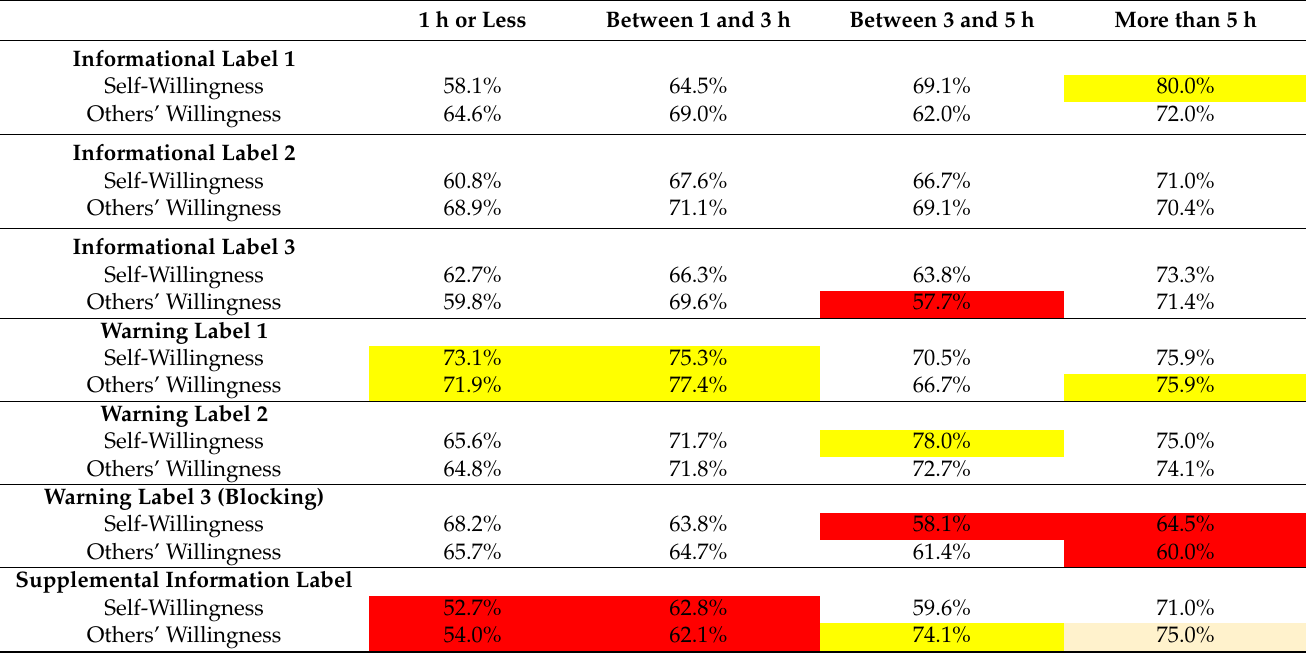
Table 6. Comparison of self- and others’ willingness to use labels by online usage level. 1 h or Less Between 1 and 3 h Between 3 and 5 h More than 5